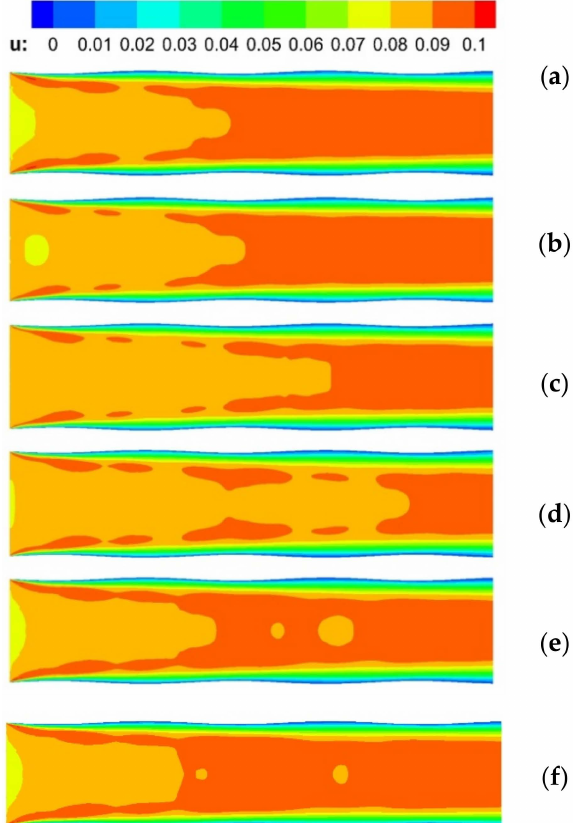
Figure 8. Velocity flow field at five monitoring points and flow field with static boundary: ( a ) Steps = 136,000; ( b ) Steps = 137,000; ( c ) Steps = 138,000; ( d ) Steps = 139,000; ( e ) Steps = 140,000; ( f ) Static boundary, steps =